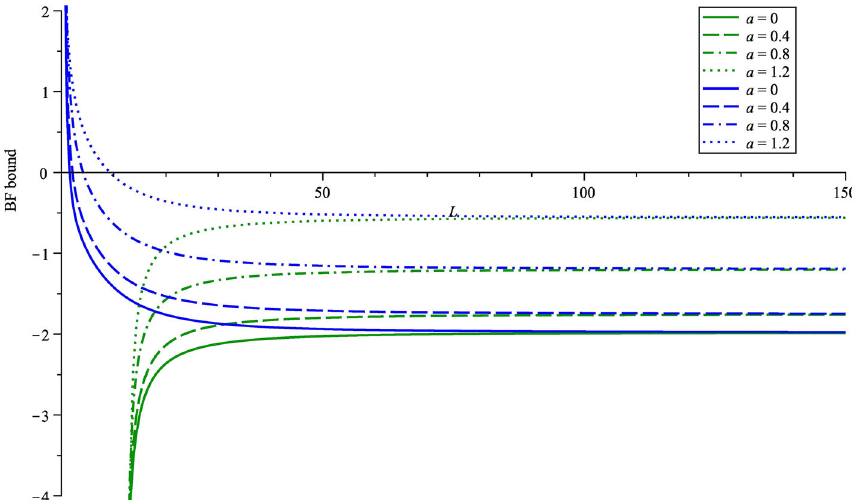
Table 1 Critical values of a and L of the BF bound in AdS: Q 2 + P 2